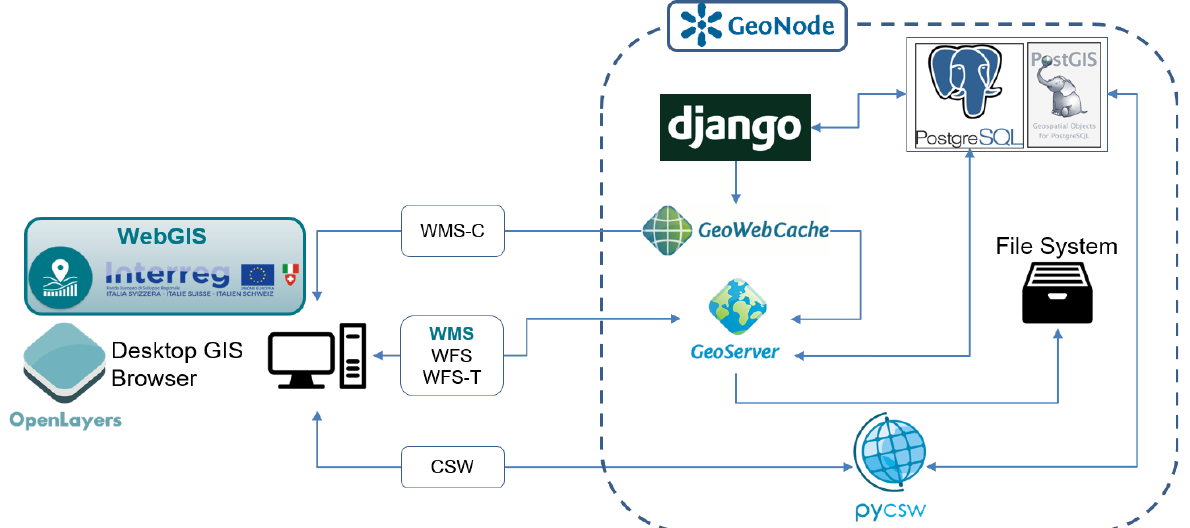
Figure 1. Schematic software architecture for the collaborative web